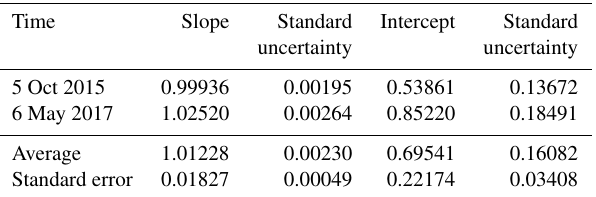
Table 2. Stability test of the ozone monitor. Time